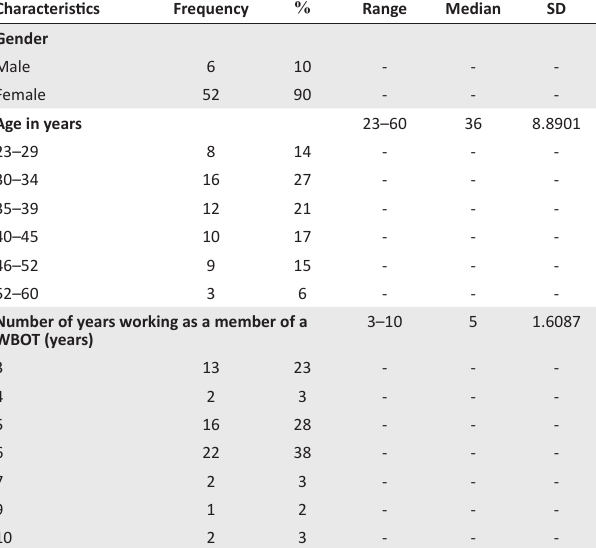
TABLE 1: Sociodemographic characteristics of participants ( n =